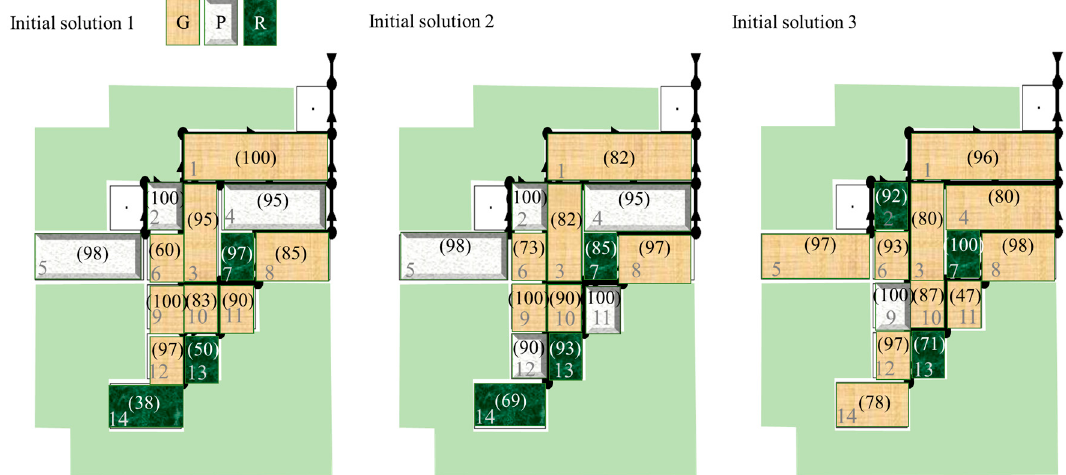
Figure 5. Types and percentages of the optimal layouts for different initial solutions.